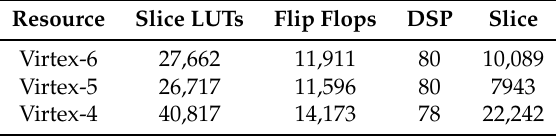
Table 3. Resource utilization on FPGA platform.